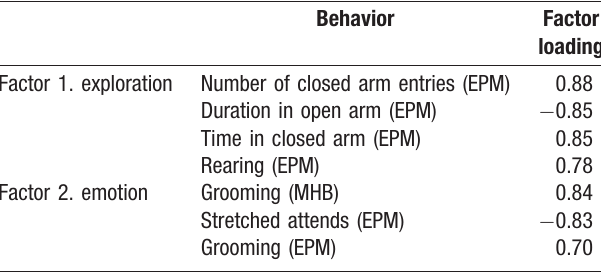
Table 5. Factors extracted and included behaviors with factor loading from naı¨ve modified holeboard (MHB) and elevated plus maze (EPM)